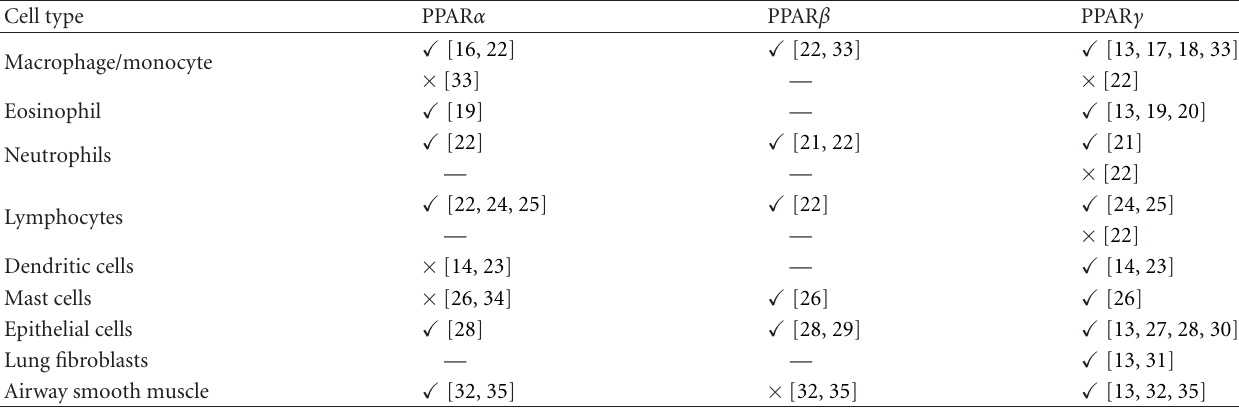
Table 2: PPAR isoforms in inflammatory cells and lung structural